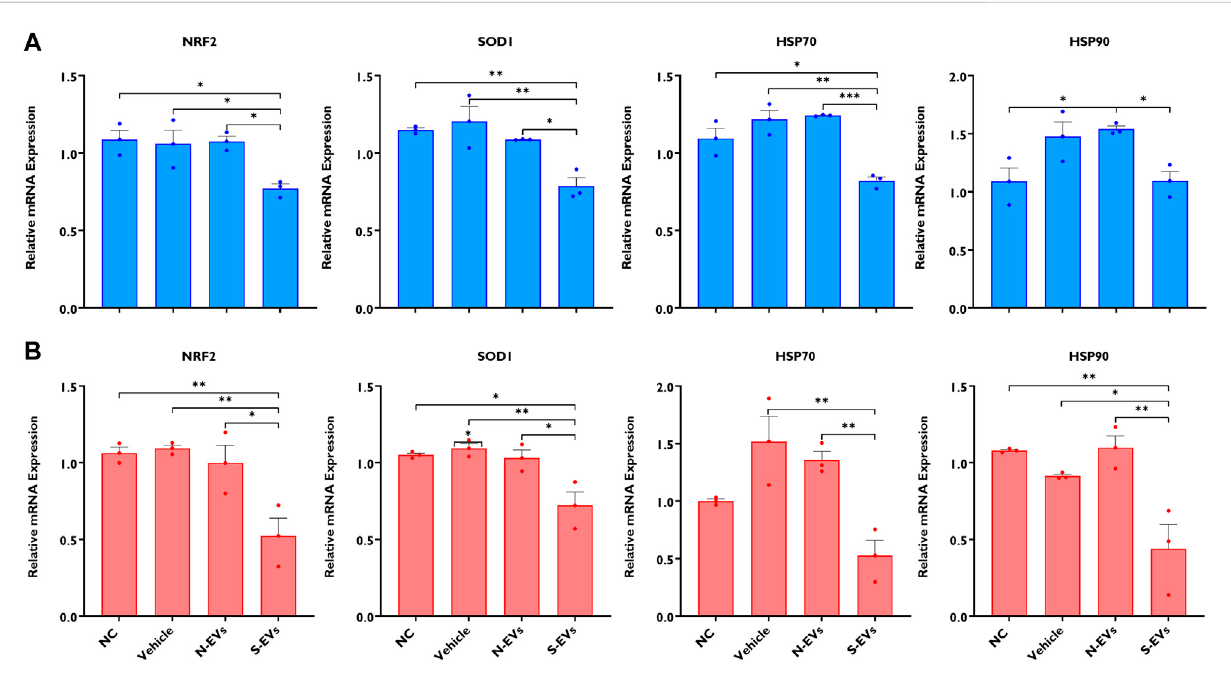
FIGURE 3 The impact of GC-EV supplementation on transcript levels of stress-associated genes in cumulus cells from cumulus-oocyte complexes following maturation at 38.5 ° C (blue) and 41 ° C (red) . The expression of stress-associated genes was signi fi cantly diminished in cumulus cells from oocytes supplemented with S-EVs and matured at 38.5 ° C (A) and 41 ° C (B) . Results are from cumulus cells removed from a total of three pools of 50 oocytes per pool for each treatment. Data represent the mean ± SEM and the differences between means were analyzed using One-way ANOVA followed